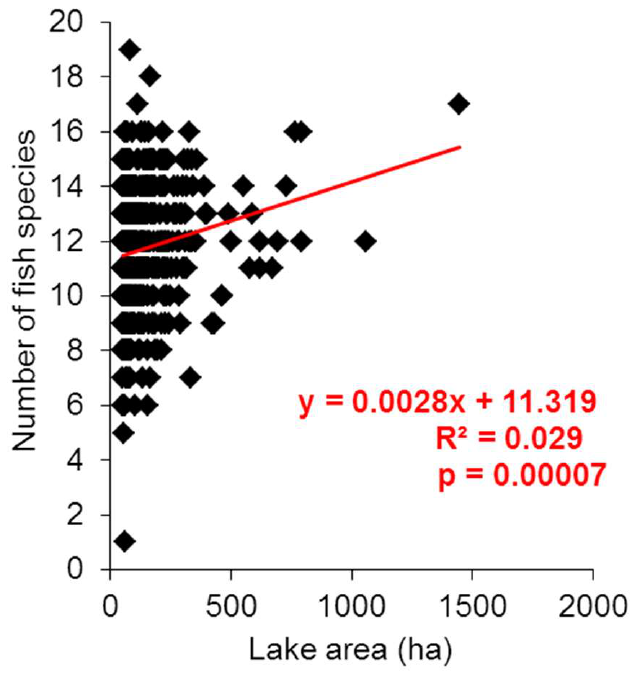
Figure 7. The relationship between the lake area and the number of fish species in 535 Polish lakes.